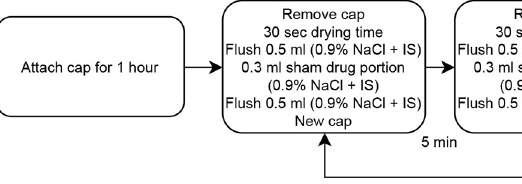
PLOS ONE | https://doi.org/10.1371/journal.pone.0235593 July 7, 2020 3 /